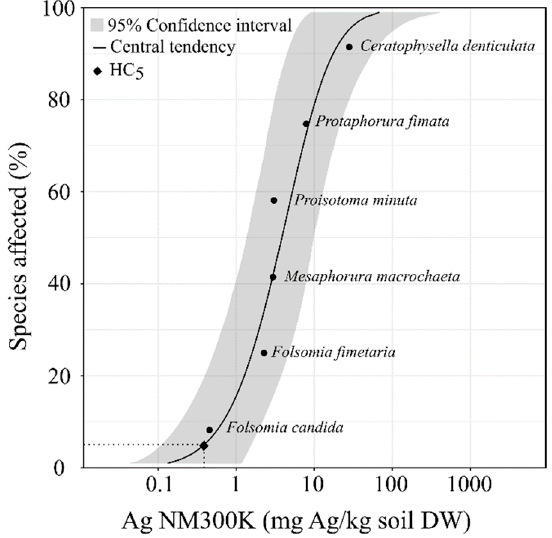
Figure 3. Species sensitivity distribution (SSD) based on chronic avoidance toxicity values (EC 10 ) of six collembolan species exposed to Ag NM300K in LUFA 2.2 soil. Solid line represents the fitted log normal model, the grey section is the 95% confidence interval, and the dashed line represents hazardous concentrations for 5% of collembolan species (HC 5 ).